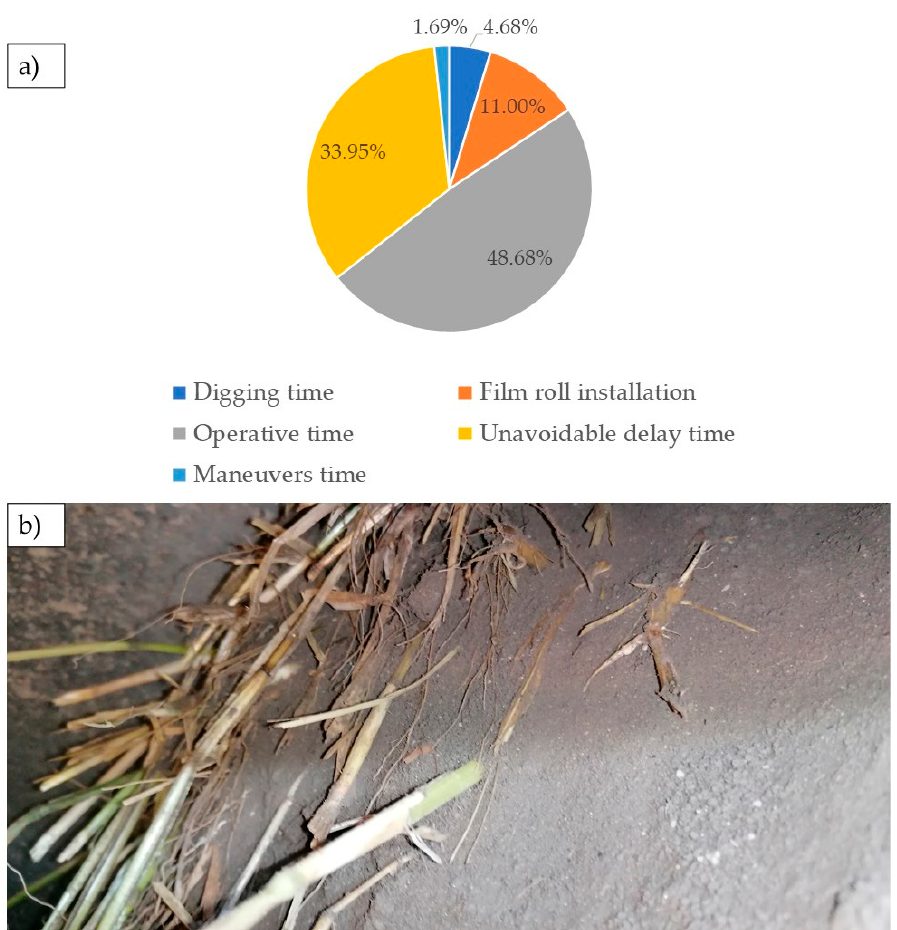
Figure 1. ( a ) Pie chart of the working times, and ( b ) image of the clogging experienced due to presence of residual biomass on the field.